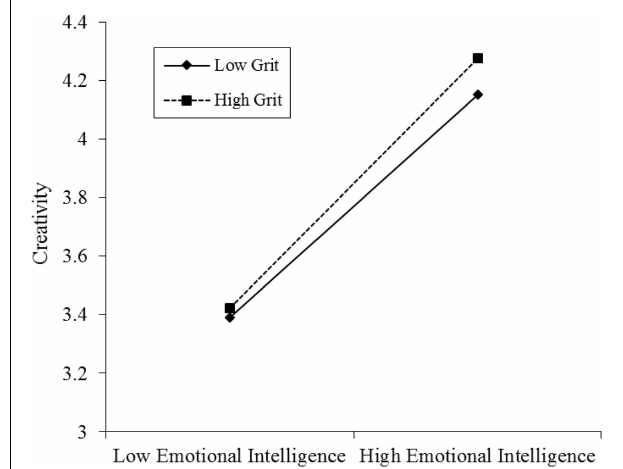
FIGURE 2 | The moderated effect of grit on emotional intelligence and individual creativity.